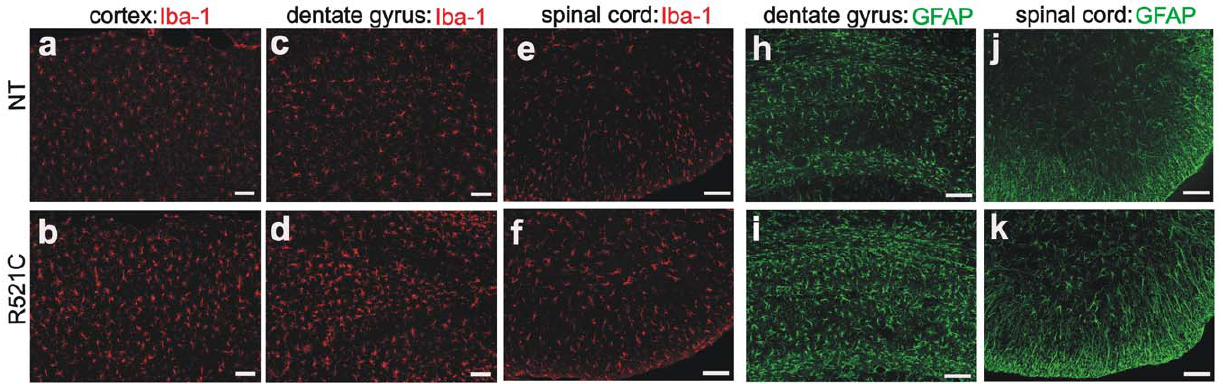
Figure 6. Proliferation of astrocytes and microglia in mutant FUS transgenic rats. (A–K) Immunofluorescence staining for the microglia marker Iba-1 (A–F) and the astrocyte marker GFAP (H–K) in the mutant FUS transgenic rats of line 16 at the paralysis stage (R521C) and in their nontransgenic age-matched littermates (NT). Coronal sections of the frontal cortex and traverse sections of the lumbar spinal cord were immunostained with antibodies to Iba-1 (red) or GFAP (green). Scale bars: 100 m m.